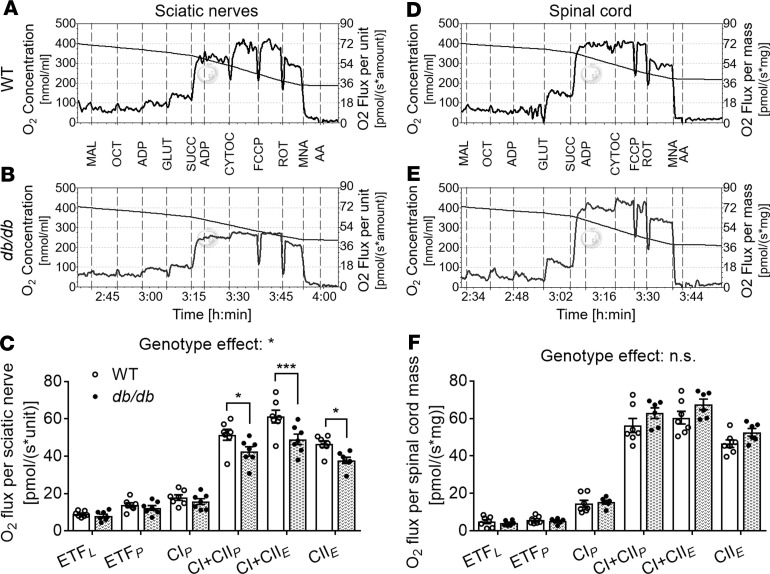
Reduced cellular respiration in sciatic nerve tissue of obese diabetic mice.Sciatic nerves (left and right) were permeabilized with collagenase, desheathed, and defluffed, while spinal cords were homogenized on a Kontes glass homogenizer in MiR06-Creatine respiration medium. High-resolution respirometry was conducted on Oxygraph-2K (Oroboros). Representative respirometric traces from sciatic nerve (A and B) and spinal cord (D and E) tissues using a substrate-uncoupler-inhibition titration (SUIT) protocol to measure oxygen consumption in WT (open circles/bars) and db/db (filled circles/bars) mice. Traces represent the oxygen concentration of the chamber (left y axis) and the oxygen flux per sciatic nerve unit or spinal cord mass (right y axis). Respiration analyses for sciatic nerve (C) and spinal cord tissue (F) are graphically represented as dot plots with bars; each dot represents 1 animal; data are displayed as the mean ± SEM of n = 6–7 male mice/genotype/tissue. Respiration parameters were compared between genotypes using 2-way ANOVA and Holm-Šidák multiple-comparisons tests on GraphPad Prism 7. *P < 0.05, ***P < 0.001. “Genotype effect” describes the global 2-way ANOVA results (considering all the measurements). The P value markers shown above brackets are from the multiple comparisons done between genotypes for each individual measure. ETFL (fatty acid oxidation in the absence of ADP [state 2]); ETFP (fatty acid oxidation coupled to ATP production); CIP (complex I-linked respiration coupled [state 3]); CI + CIIP (complex I and complex II-linked respiration coupled [state 3]); CI + CIIE (complex I and complex II-linked respiration uncoupled [maximum respiration]); and CIIE (complex II activity uncoupled). Experimental mice were 2–2.5 months old. MAL, malate; OCT, octanoylcarnitine; GLUT, glutamate; SUCC, succinate; CYTOC, cytochrome c; FCCP, carbonylcyanide p-trifluoromethoxyphenylhydrazone; ROT, rotenone; MNA, malonic acid; AA, antimycin A.